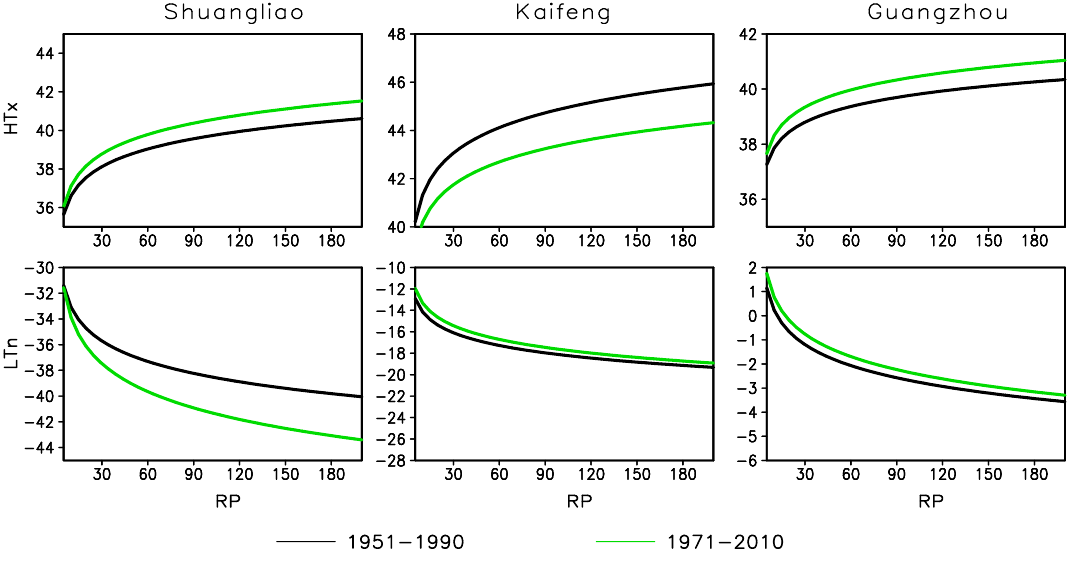
Fig. 4 Extreme values of different RP derived from observed HTx (Top panel) and LTn (Bottom panel) samples of three selected stations in two periods (The black line is for P1 and green for